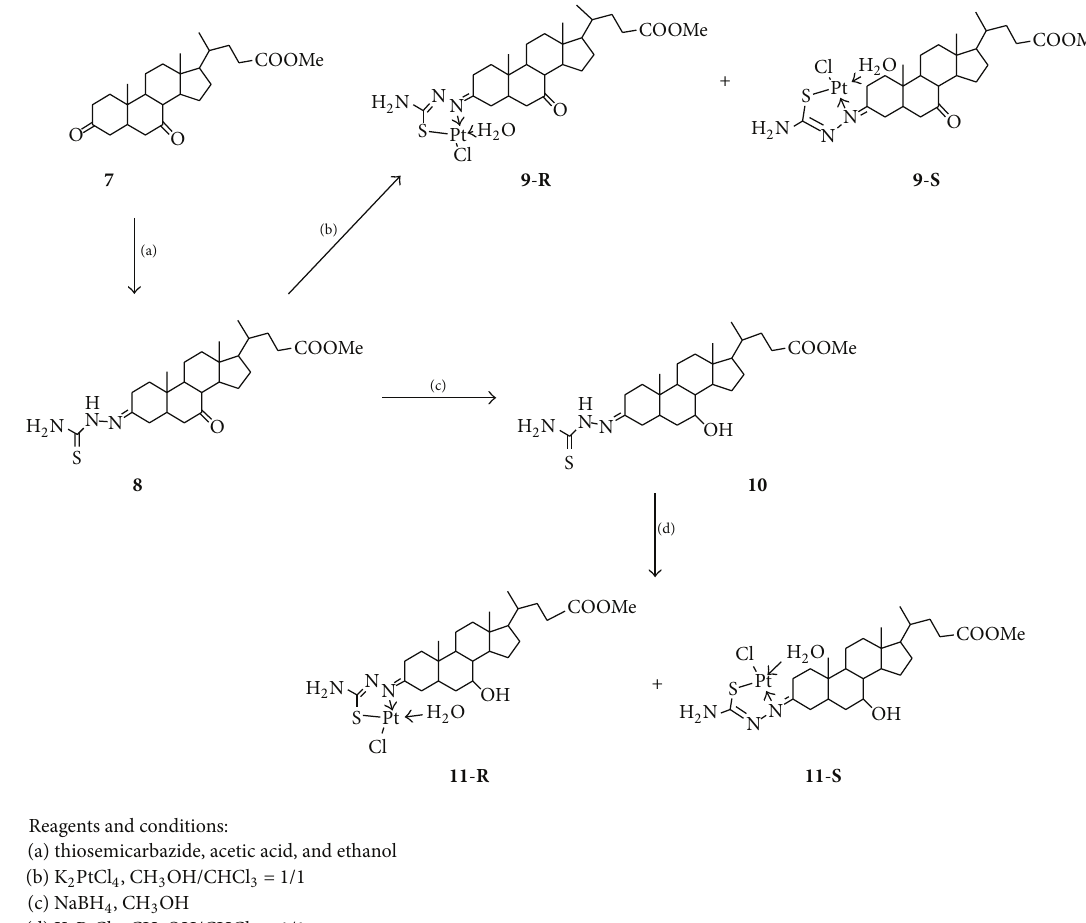
Scheme 1: Synthesis of estrone-17-thiosemicarbazone platinum(II).